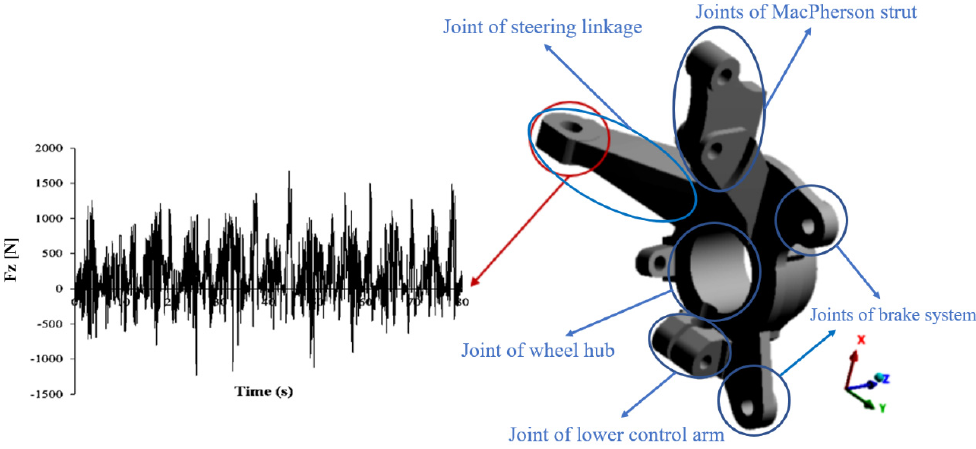
Figure 6. The details of loading history, its location, and the applied direction in the present research.